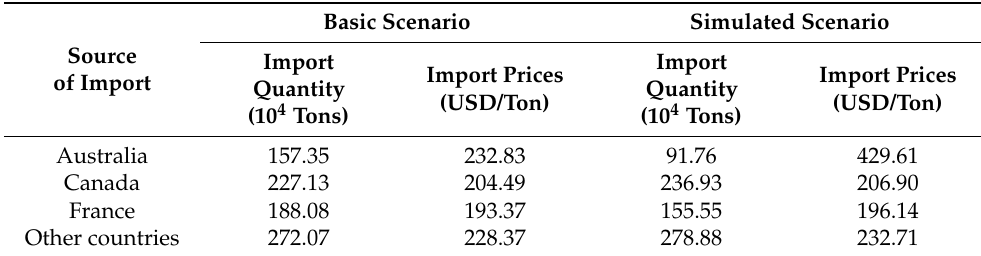
Table 7. Simulation results of changes in China’s barley import trade (Scenario 1).